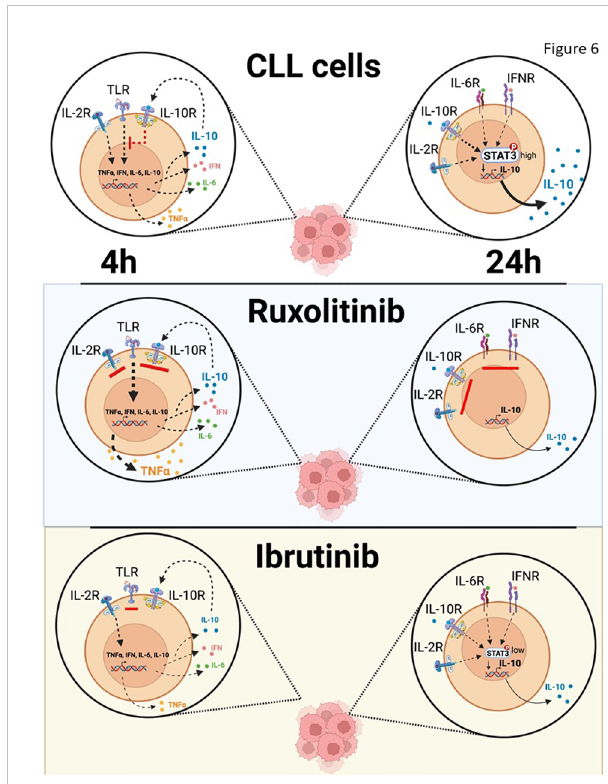
FIGURE 6 Schema of effect of IL10 on TLR-signaling in vivo . IL-10 sustained in part by IL-6 or possibly IFN suppresses TLR-7-signaling in CLL cells, which is unleashed by ruxolitinib to make NF k B-regulated cytokines such as TNF a . Ibrutinib also blocks IL-10 production by CLL cells but prevents their activation by partially inhibiting the NF k B pathway directly and remaining susceptible to paracrine and endocrine IL10 from sources other than CLL